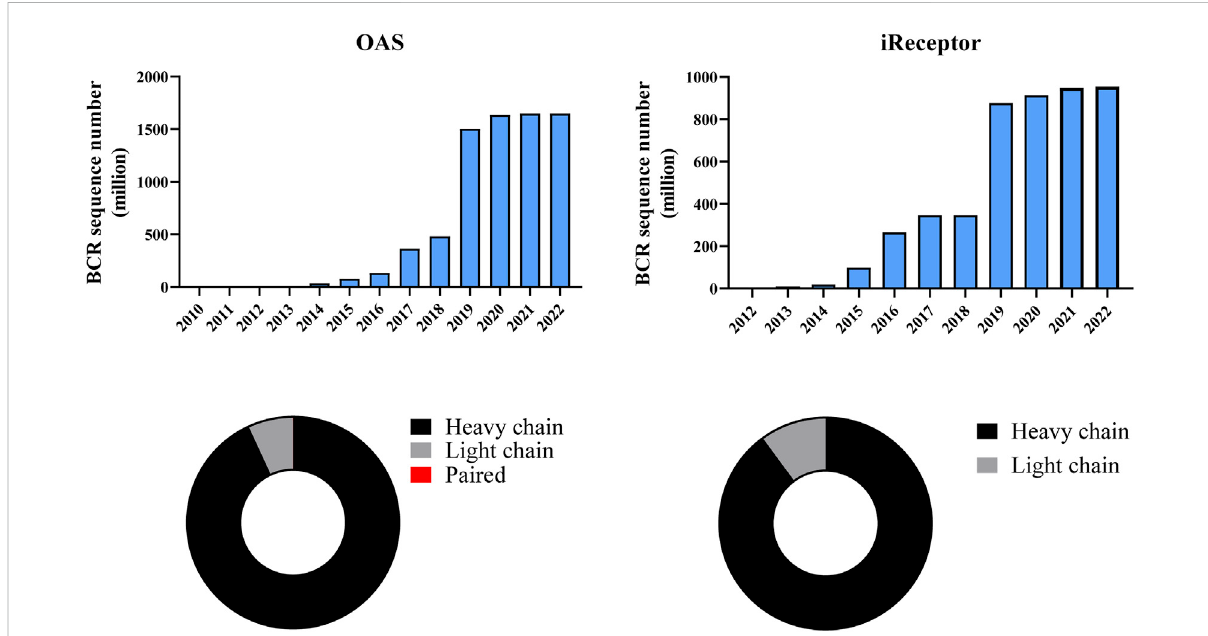
FIGURE 4 Metadata available in OAS and iReceptor. The bar chart shows the cumulative growth of BCR sequence data. OAS provides about 1,650 million